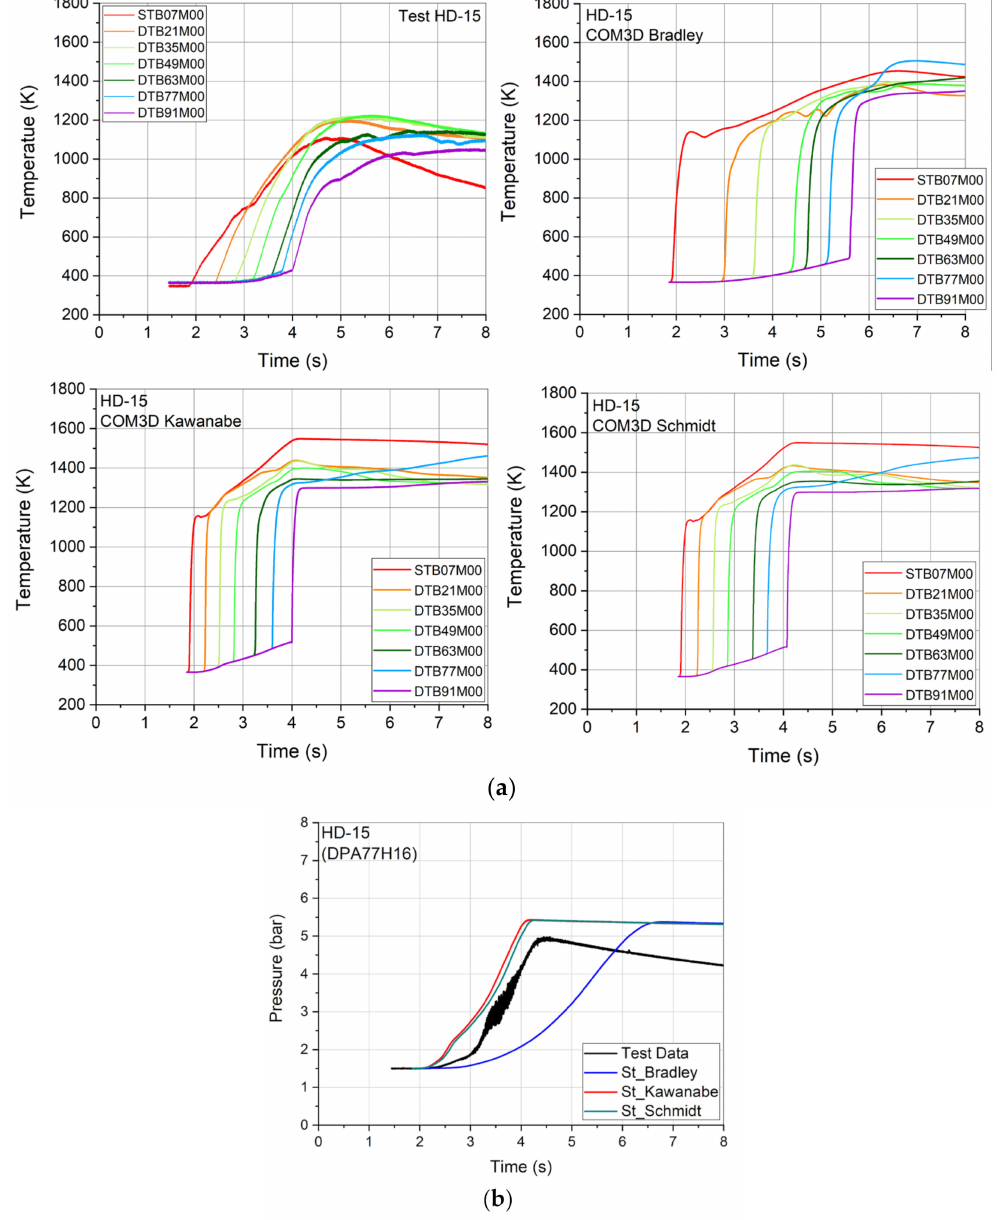
Figure 4. COM3D results for the THAI test HD-15. ( a ) Measured and calculated temperatures along the centerline of the vessel. ( b ) Comparison of pressure at the elevation 7.7 m between the test data and the COM3D